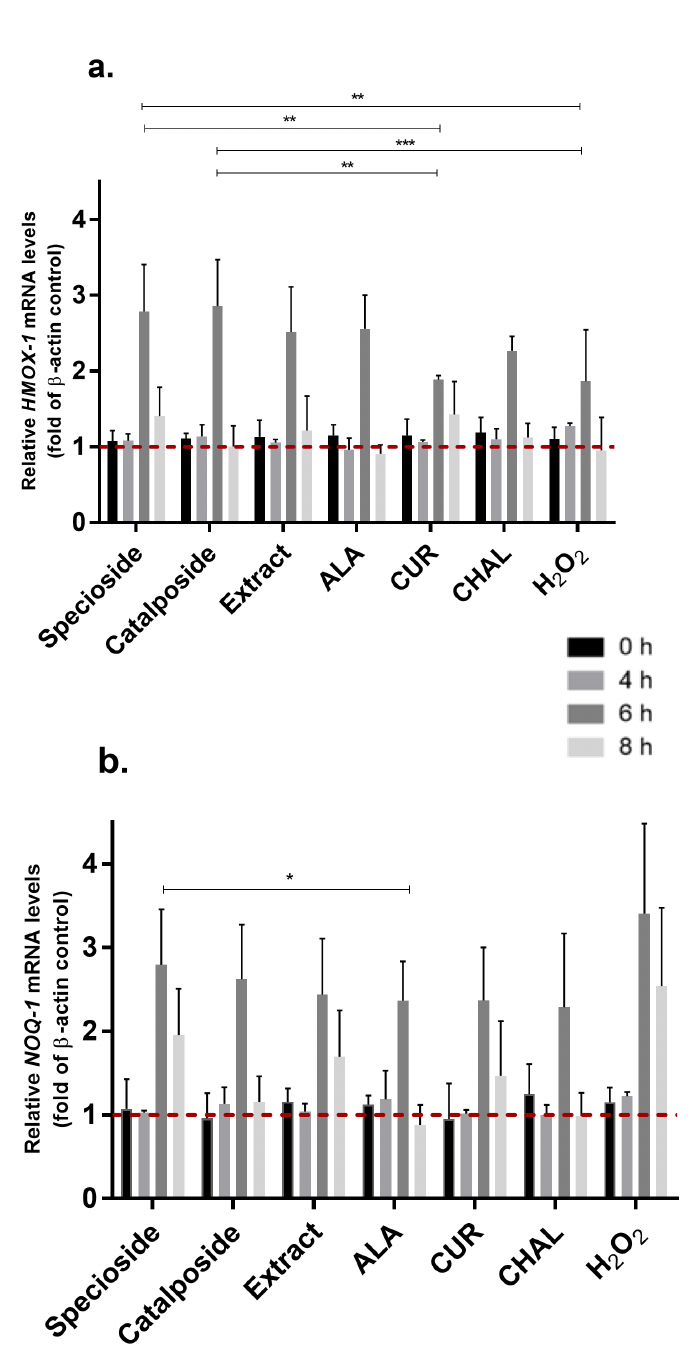
Figure 4. Relative HMOX-1 ( a ) and NQO1 ( b ) mRNA levels after 0, 4, 6 and 8 hours post-exposure to 0.5 µM (pure compounds), 0.25 µg/mL ( n -butanol extract) and induction of oxidative stress with 0.98 mM (H ALA, α-lipoic acid; CUR, curcumin; CHAL, 2-trifluoromethyl-2ʹ-methoxychalcone.